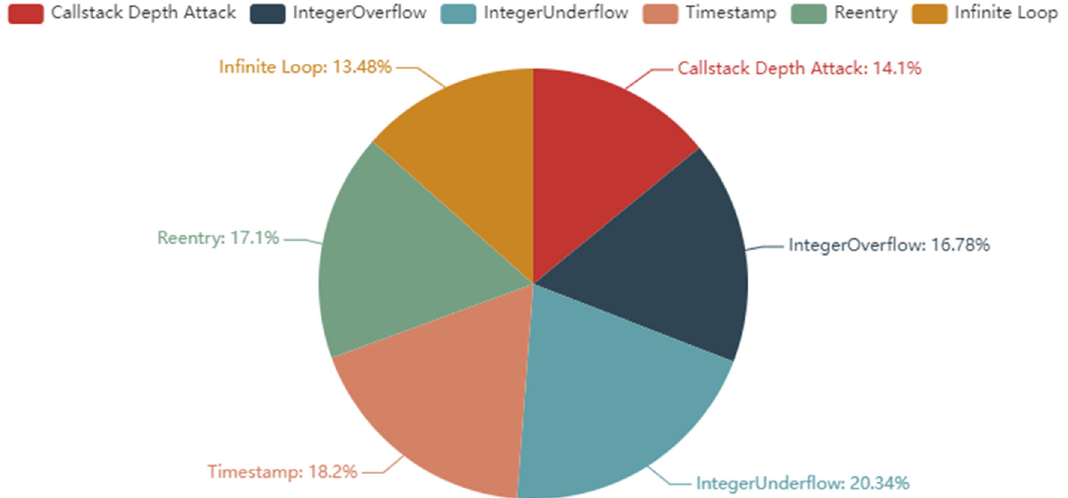
Figure 9. Distribution of the number of vulnerabilities.